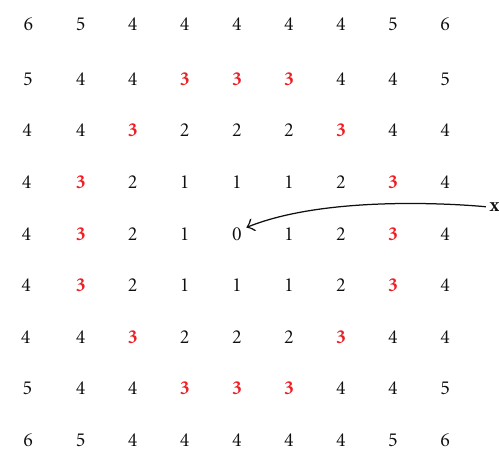
Figure 1: Each pixel is shown as a number indicating its integer distance from the central pixel. If we denote the central pixel as x , then pixels labeled n are members of the set H n ( x ). For example, the pixels labeled “3” (shown in bold) comprise the shell H 3 ( x